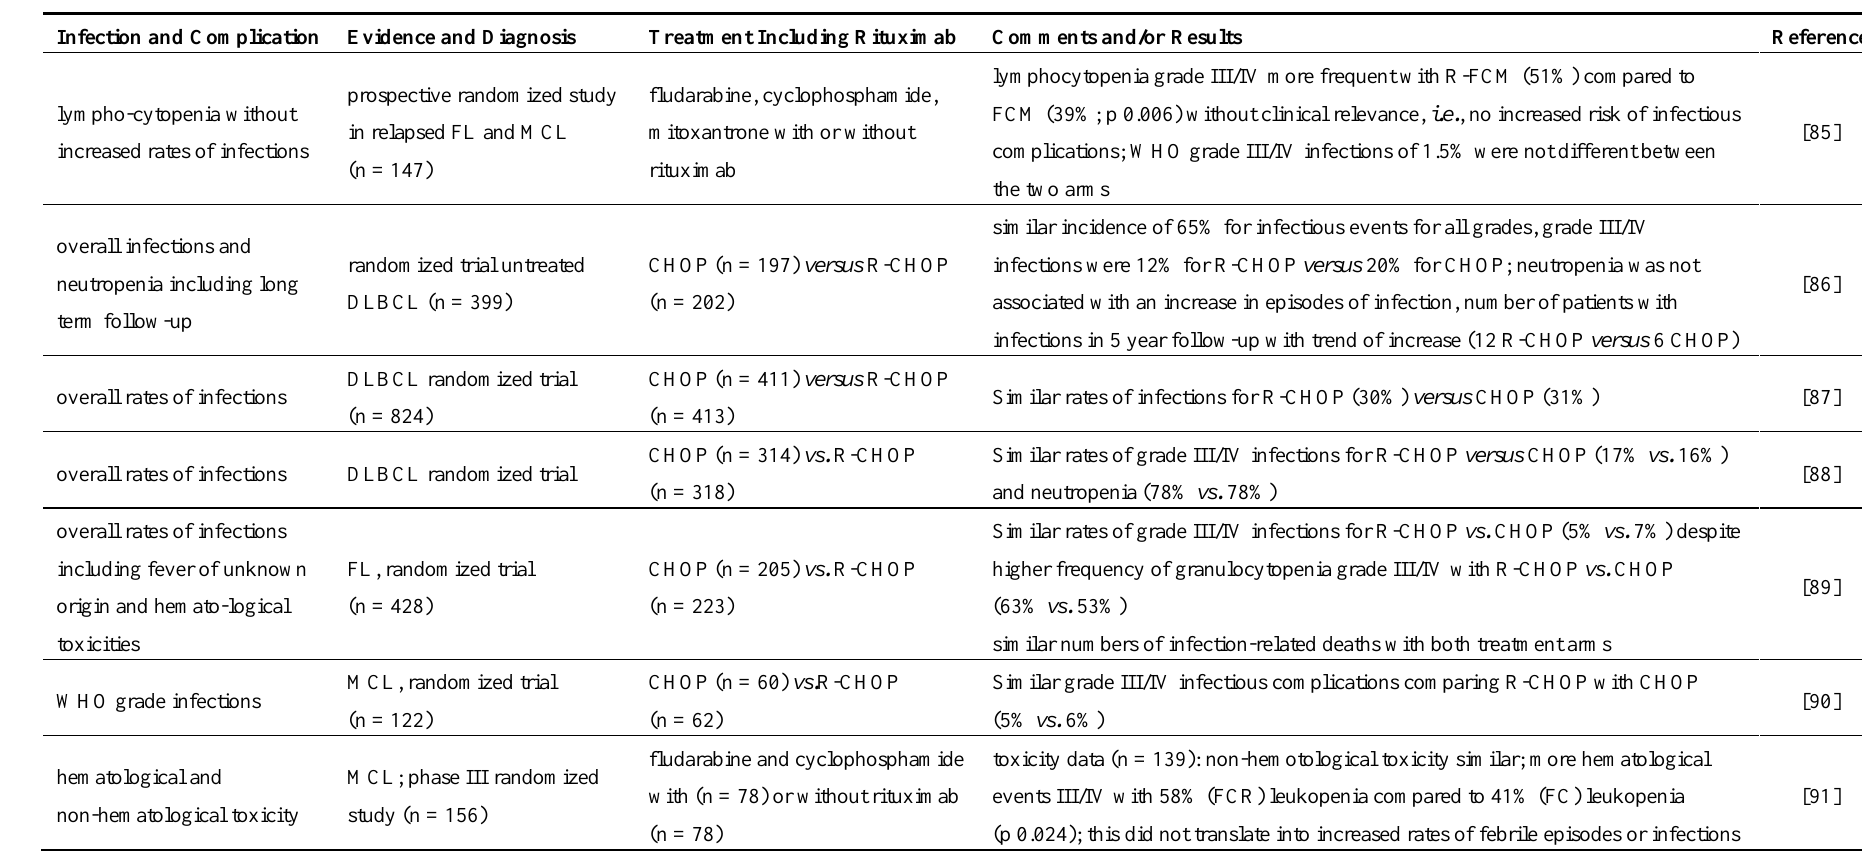
Table 4. Infectious complications in randomized controlled trials comparing chemotherapy alone versus chemotherapy combined with rituximab for NHL